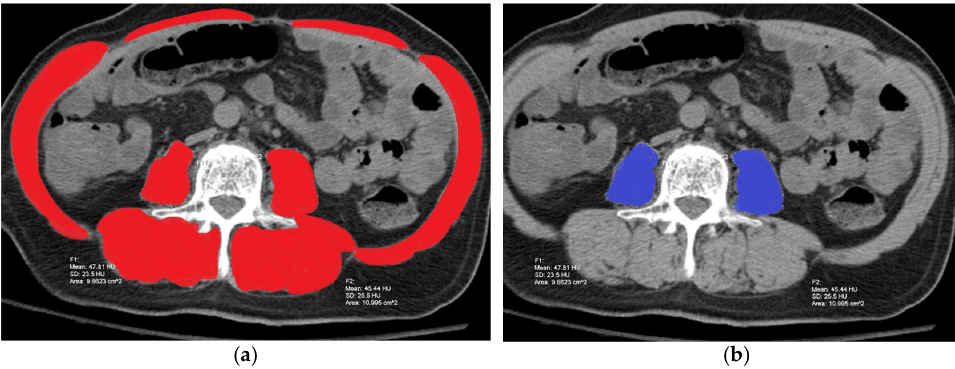
Figure 2. CT scan of a 68-year-old male patient at L3 demonstrating how sarcopenia is assessed based on measurement of SMI in red ( a ) as defined by cross-sectional areas of psoas, erector spinae, quadratus lumborum, transversus abdominis, rectus abdominis, and internal and external obliques, and measurement for psoas muscle area (PMA) in blue ( b ) as measured by the sum of the areas of the psoas alone.